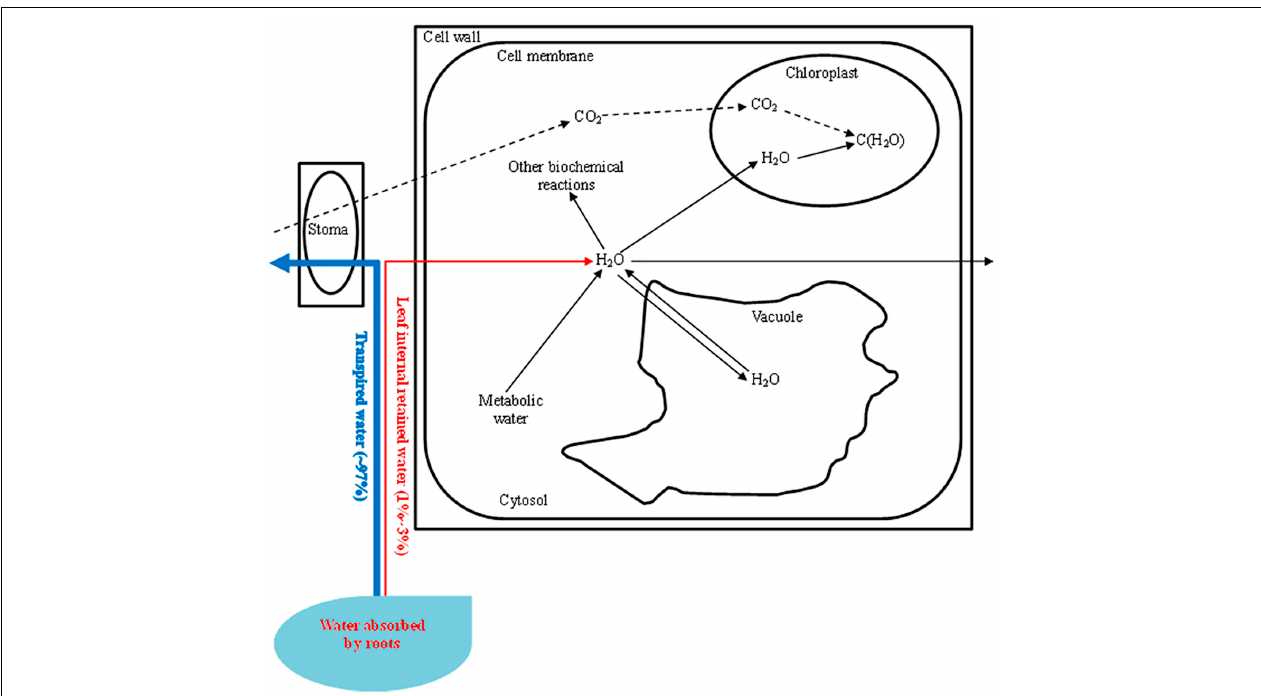
FIGURE 4 | Leaf intracellular water transport [most ( ∼ 97%) of the water absorbed by roots is transported through the stoma. Leaf internal retained water (1–3%) is transported in cells and is supplied to the photosynthetic apparatus and other biochemical reactions. The intracellular water status can also be regulated by metabolic water. The leaf water potential ( (cid:57) L ) can be influenced by the solute concentration in the vacuole, while the inherent leaf intracellular water transport rate (LIWTR i ) is related to the transport of intracellular water or dielectric materials. Decreasing the water supply will increase the LIWTR i but decrease the (cid:57) L , and the variation in LIWTR i combined with (cid:57) L determines the utilization traits of the intracellular